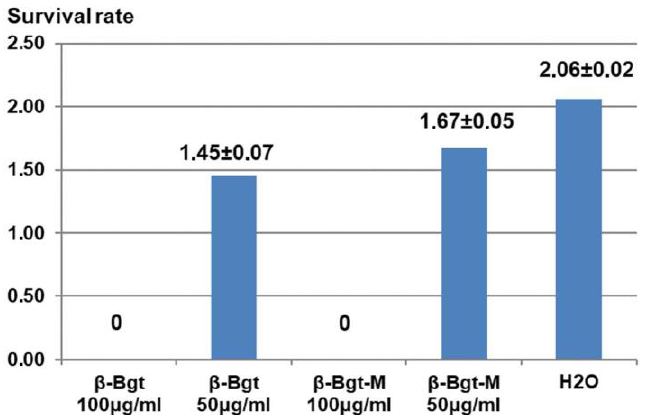
Figure 9 . Toxicity to the Tetrahymena of fraction IV-18- 2 (β - Bgt) and modified toxin (β -Bgt-M) in 24 h experiment. Survival rate is the ratio of the number of live ciliates after 24 h of incubation to the number of ciliates at the beginning of the experiment. Three independent measurements were performed for each concentration.